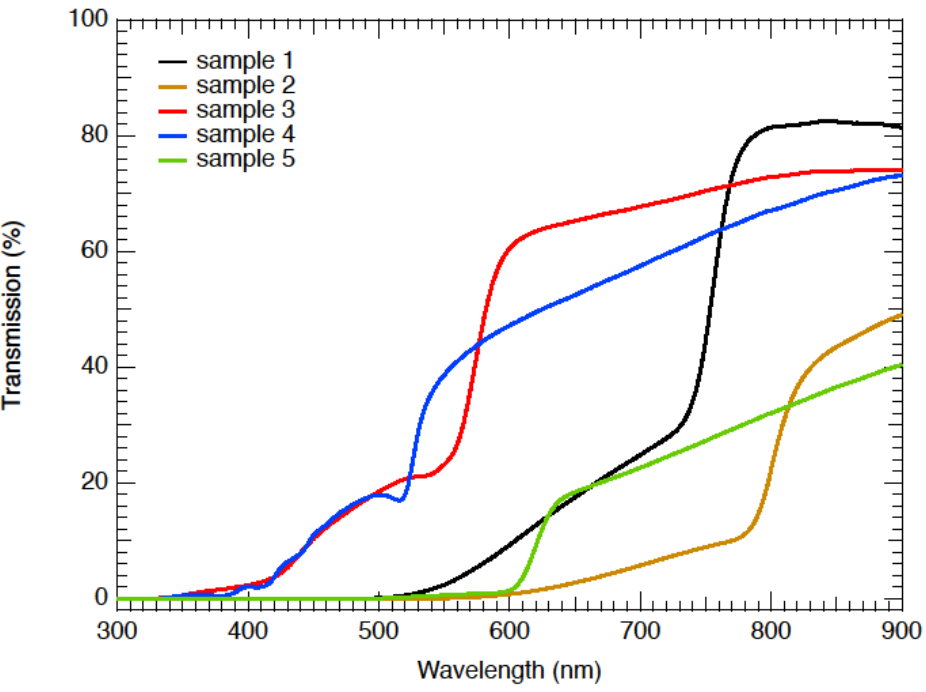
Figure 4. Optical transmissions of the perovskite films with varying anion compositions. It is apparent that the visible transparency window increased (blue-shift of the ab- sorption edge) as the % of Br relative to I increased, as shown in ascending order of the follows: sample 2 (Br/I = 0), sample 1 (Br/I = 0.20), sample 5 (Br/I = 1) and sample 3 (Br/I = 4.9). This is consistent with the previous literature [5,20] and results from the con- traction of the lattice when bromide (radius: 1.96 Å) replaced iodide (radius: 2.19 Å). The same consistent trend occurred, when smaller chloride particles (radius: 1.81 Å) replaced iodide for samples 4 and The optical bandgap can be obtained from a Tauc analysis [21] of the absorbance data (absorbance = − log(T)) with the results shown in Figure 5.